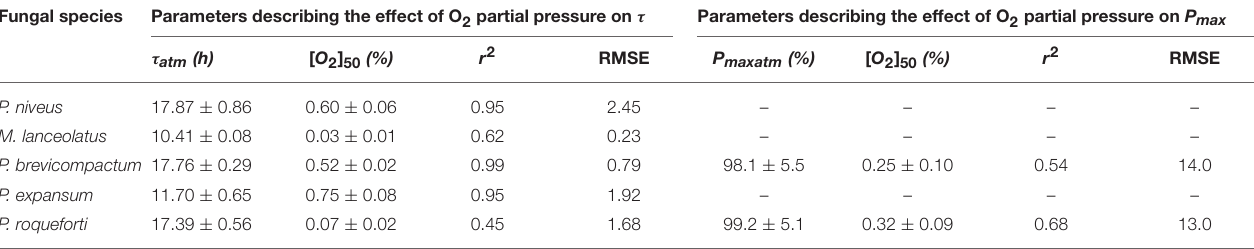
TABLE 2 | Secondary model parameters ± standard deviation obtained by fitting Equation (2) to median germination times τ (h) or Equation (3) to maximum germination percentages